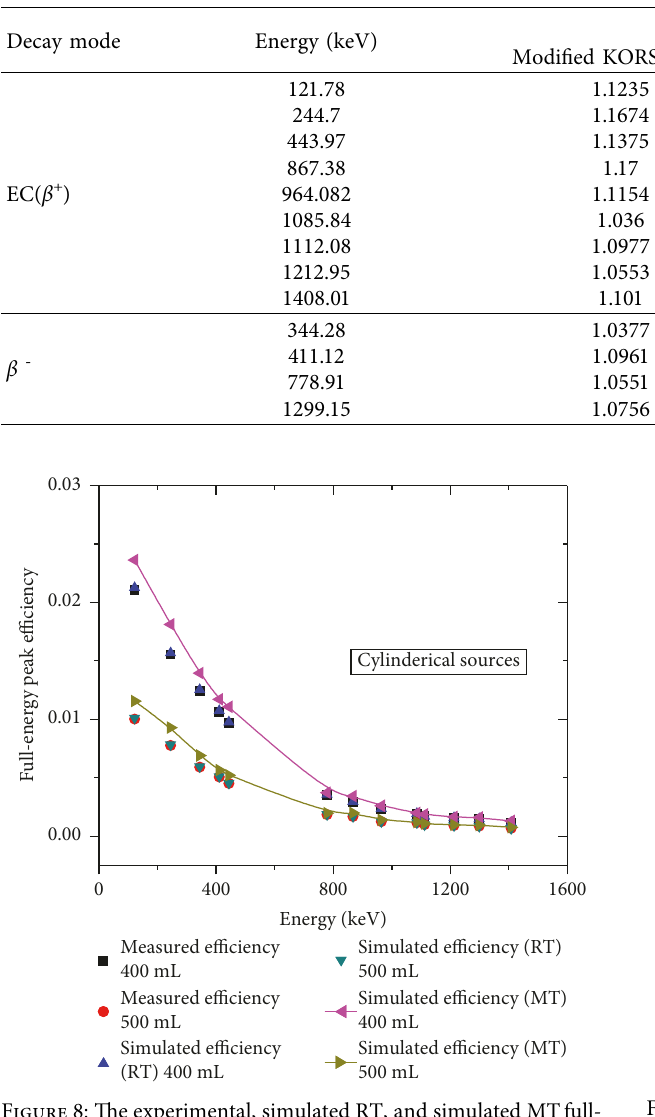
Figure 8: The experimental, simulated RT, and simulated MTfull- energy peak efficiency for different cylindrical volumetric 152Eu sources as a function of different c -ray energies as a function of different c -ray energies.